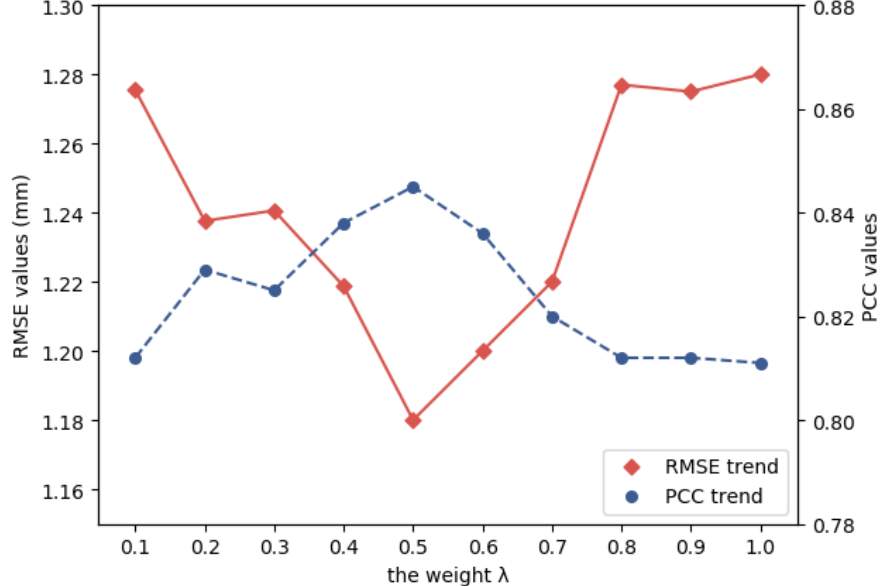
Figure 6. A line graph for analyze the impact of λ on the two aspects. the red line with diamond illustrates RMSE trend, and the blue line with circle represents PCC trend. λ = 0.5 the model acquires the best performance in the two measurements’ aspects. The results when λ approaches 0.1 or 0.9 is nearly the same. But using pure PCC target achieves a fairly large RMSE which cannot be illustrated in the line